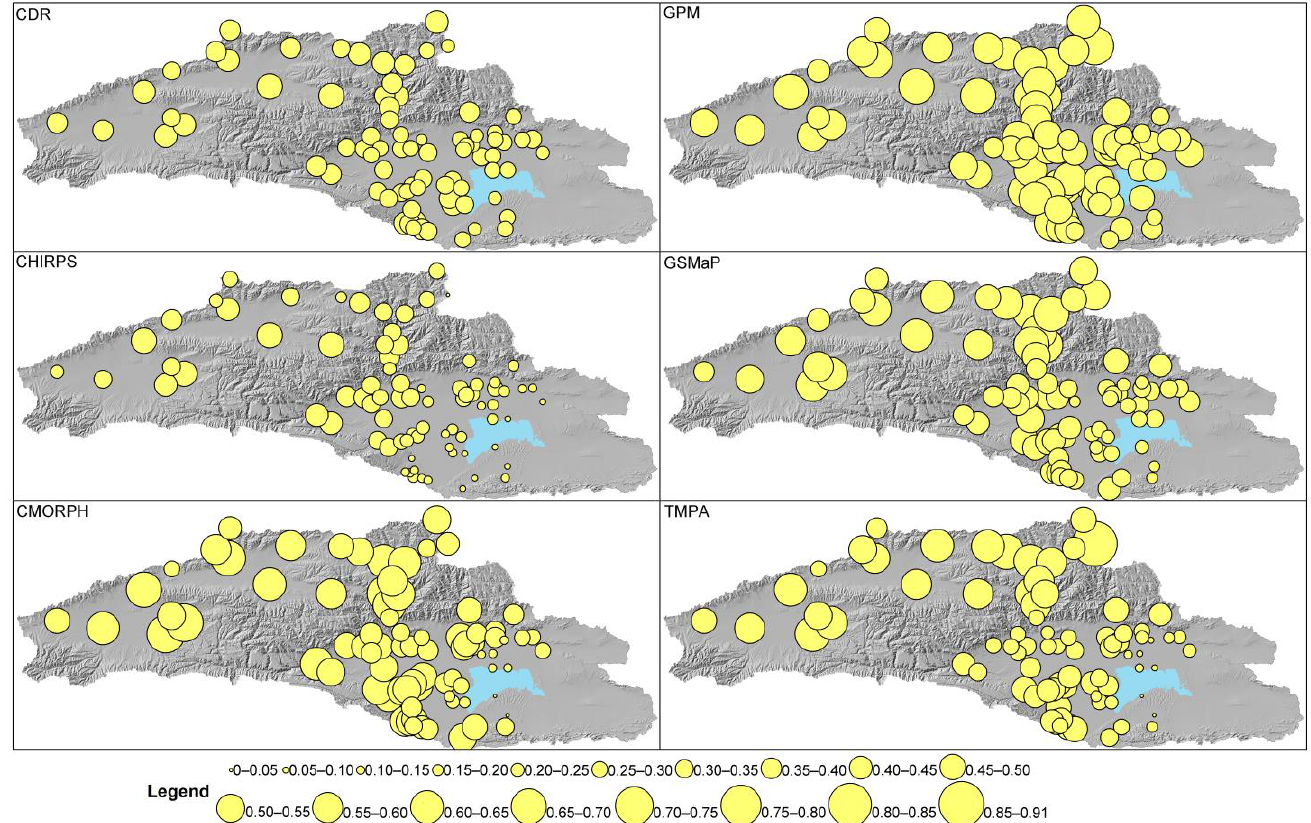
Figure 5. Distribution of CC between satellite datasets and measured data at different stations in the basin.